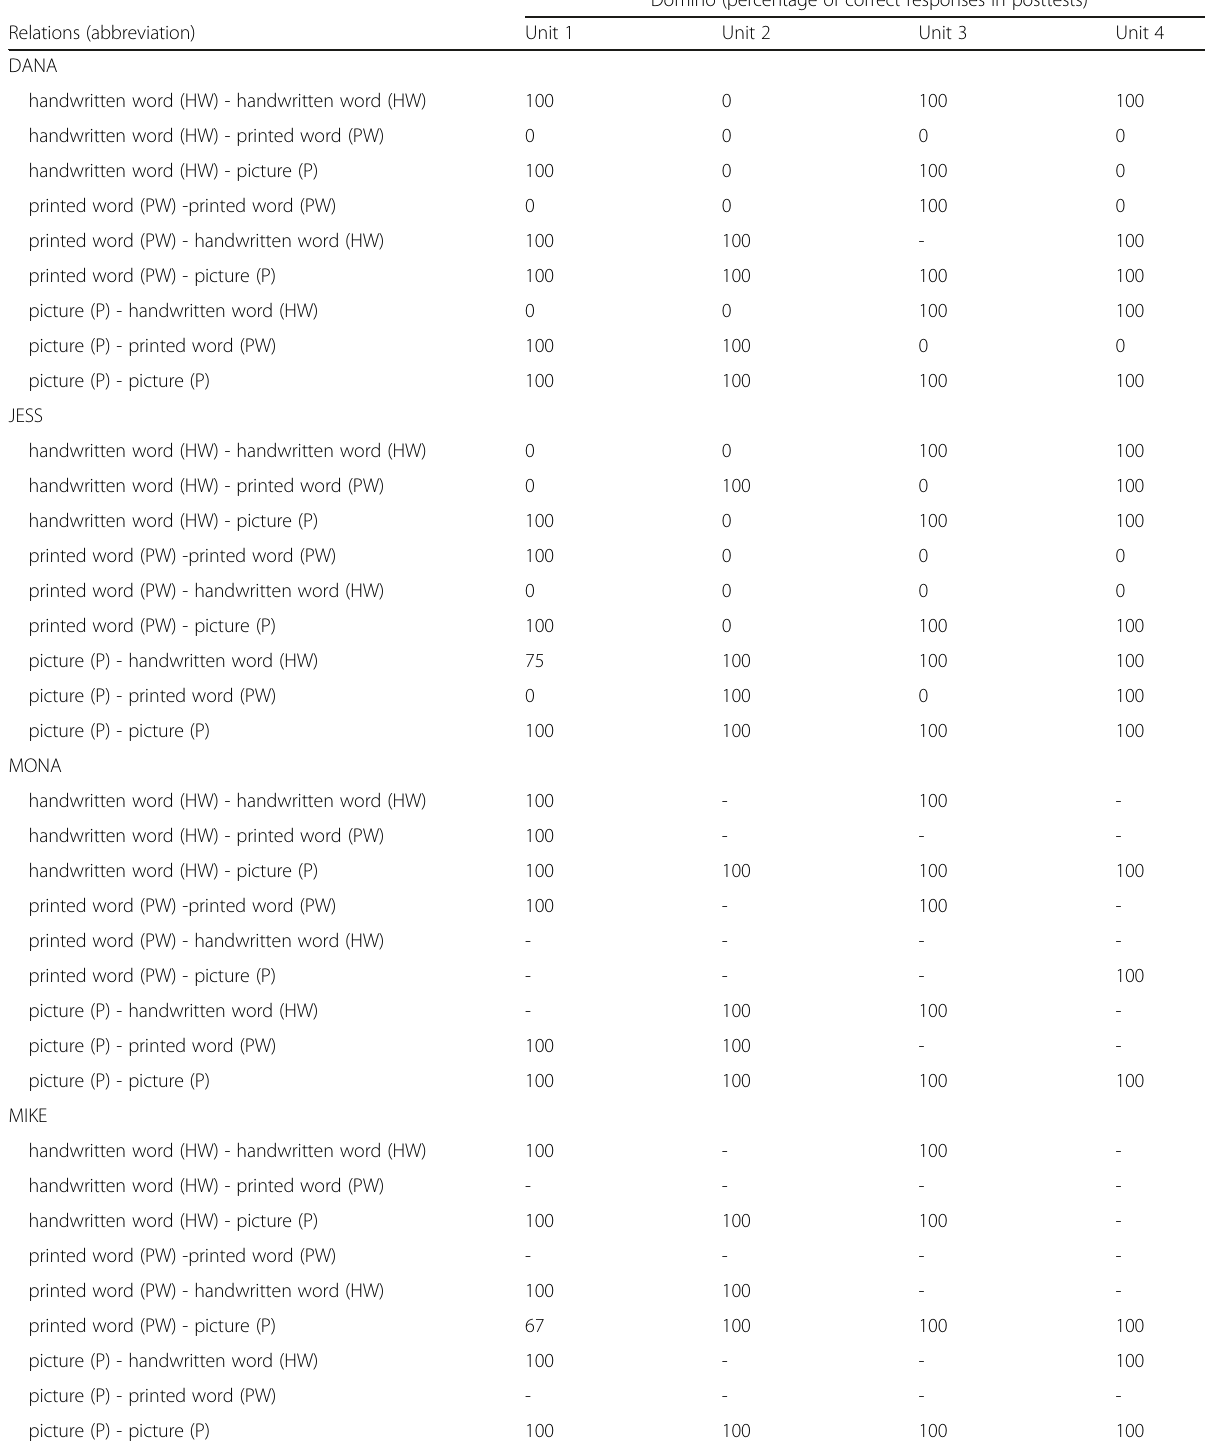
Table 2 Participant scores in each conditional relation tested in domino posttest